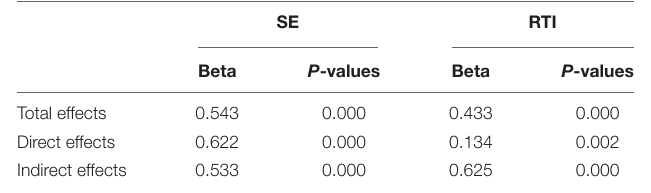
TABLE 4 | Mediation